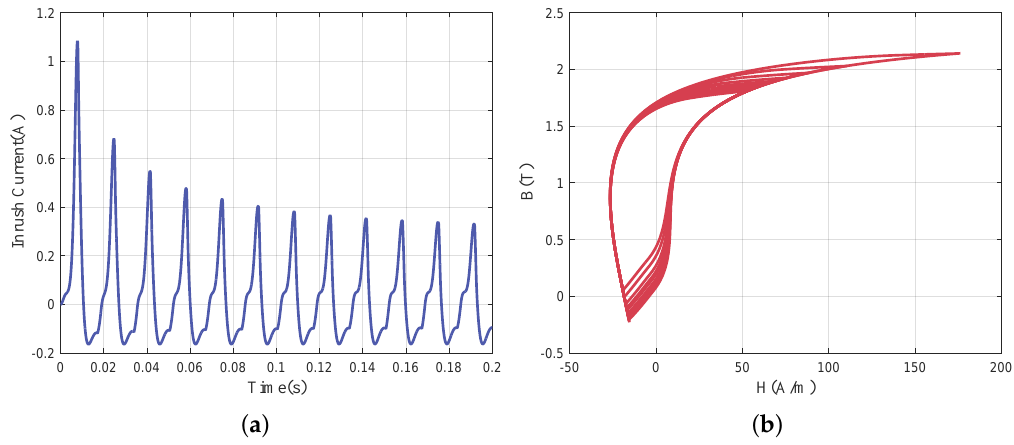
Figure 3. Inrush current curve ( a ) and the corresponding Hysteresis loops ( b ).